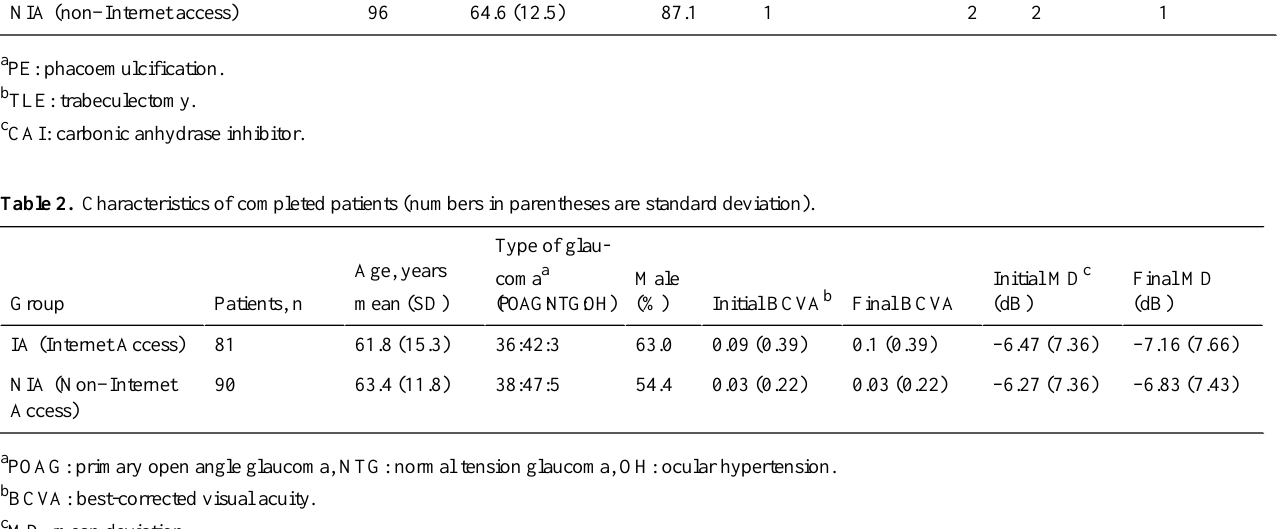
Details of dropout during the IA periodStart of IAGroup